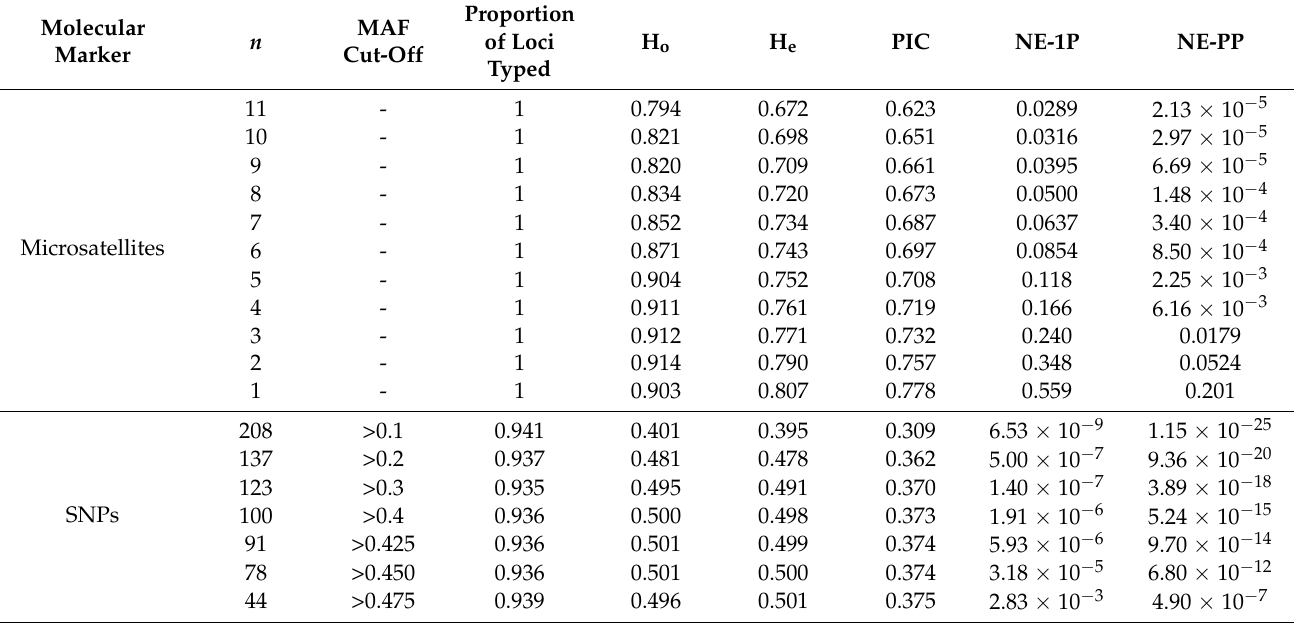
Table 1. Genetic characterization and combined non-exclusion probability for parent of microsatellites and SNPs. Molecular